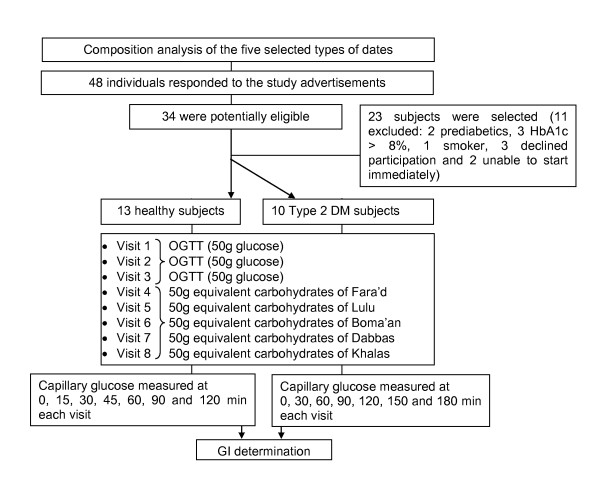
Study flow chart.